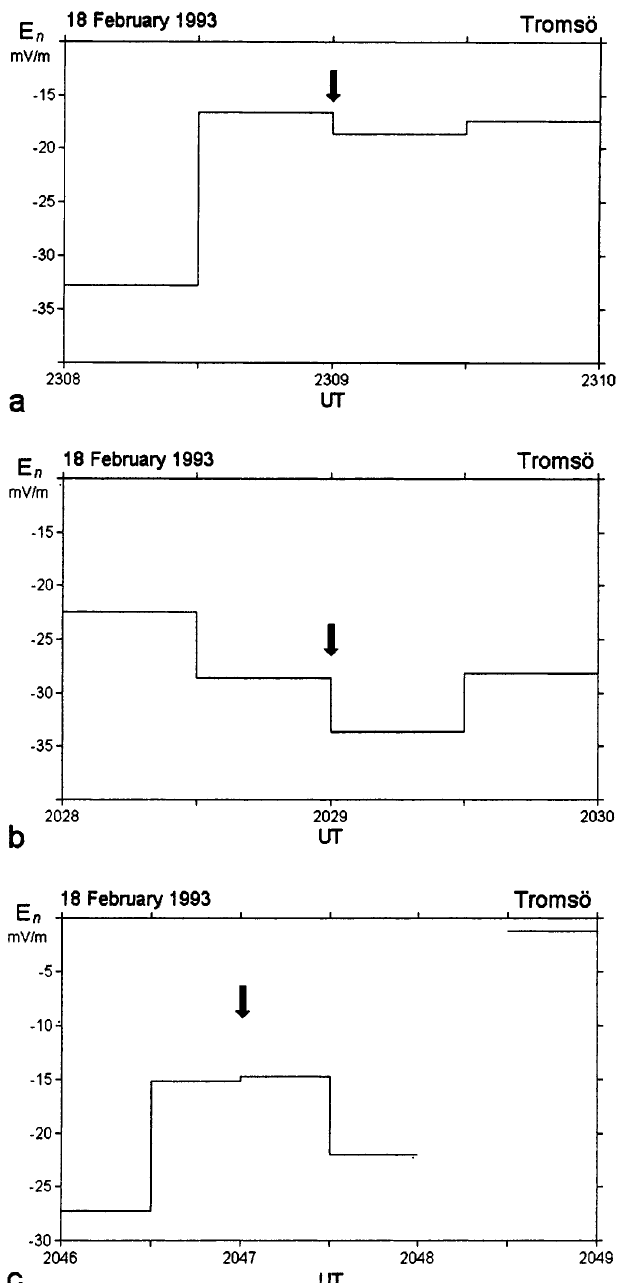
Fig. 9a–c. Variations of the meridional component of ionospheric electric field through the intervals under consideration. Black arrows indicate the times of azimuthal